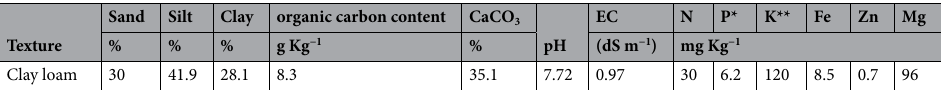
Table 1. The characteristics of the original soil used in the experiment. *Olsen available. **Available potassium (Kavail).